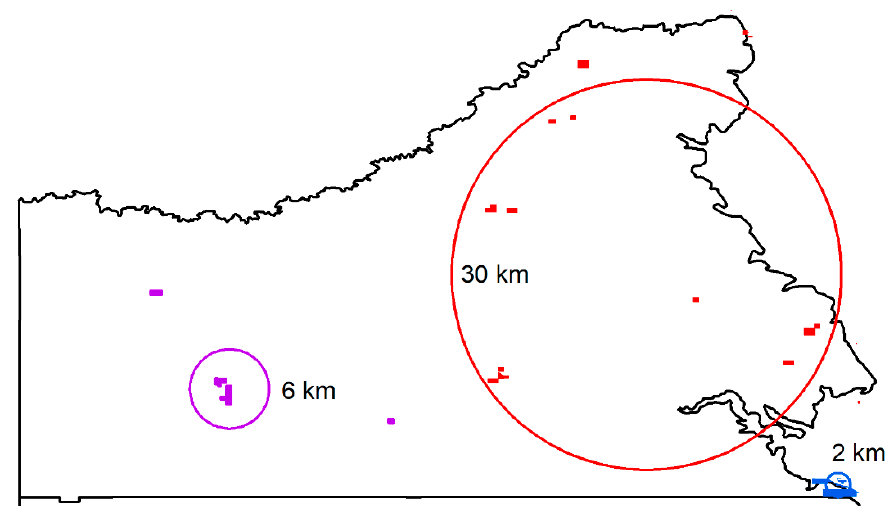
Figure 16. Spatial patterns of three different Standing Rock families in purple, blue and red. The circles are Standard Distances, or a measure of dispersion around a geometric mean center of these family allotments. Some families received allotments in clusters, in blue and purple, and other families were widely dispersed, in red.